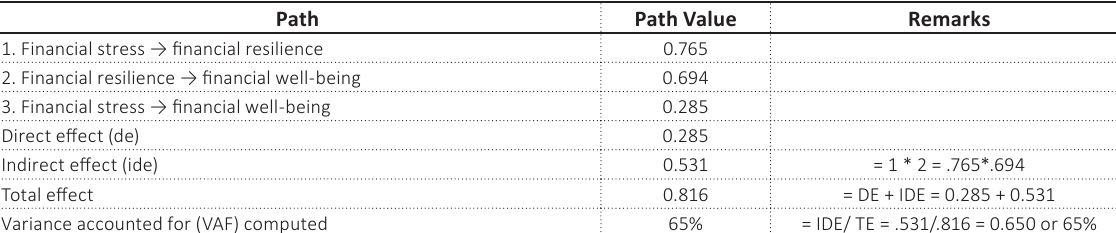
Table 7. Mediation effect of financial resilience